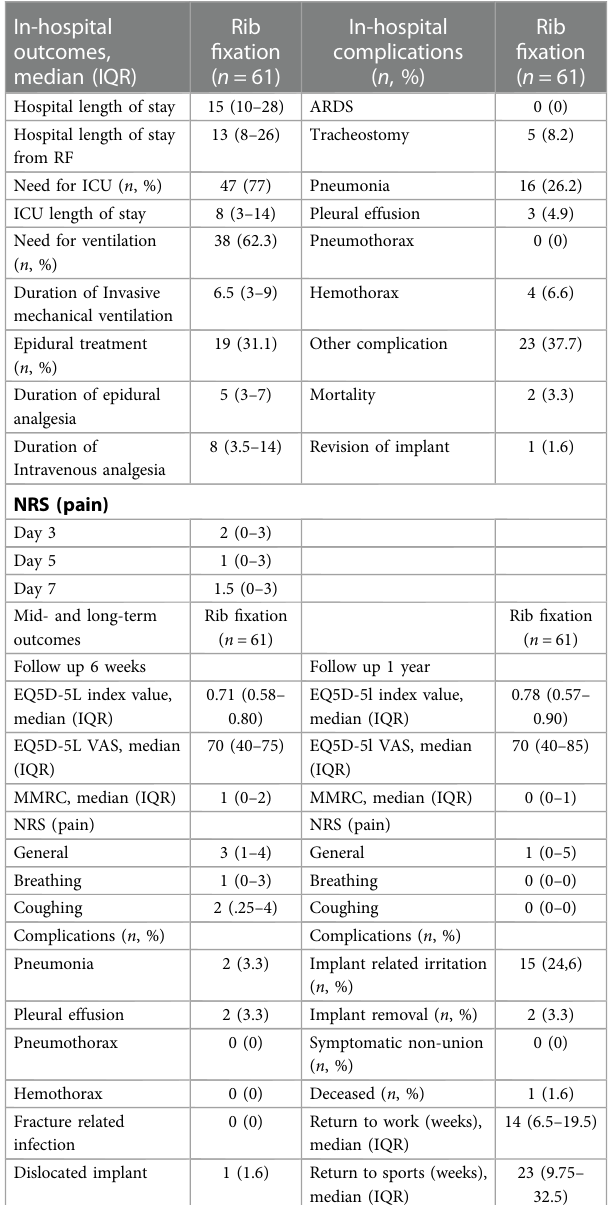
TABLE 2 Outcomes of operatively treated patients with fl ail chest injuries.